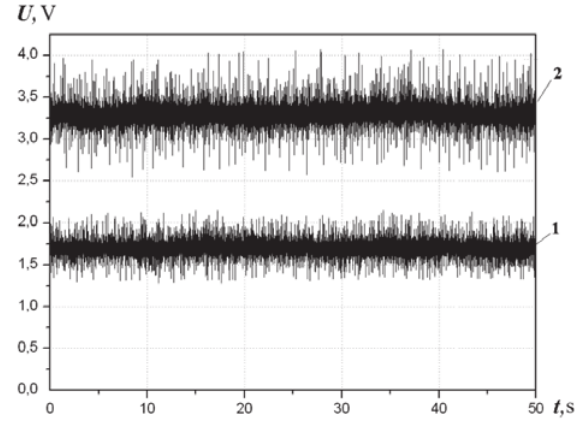
Fig. 6. AE resultant signals recorded during tests of the friction pair with a CM coating wear at different rotation